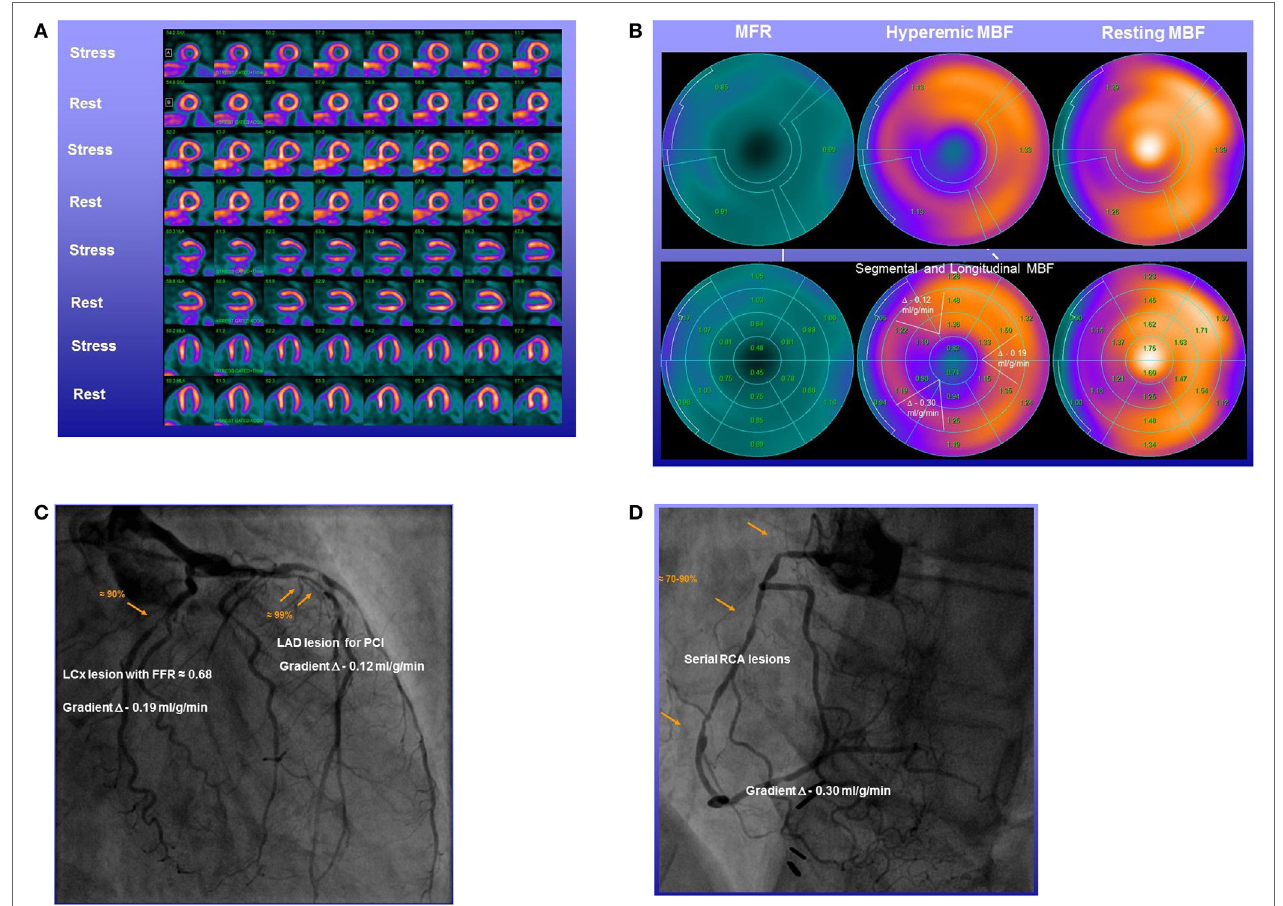
FiGURe 6 | Abnormal longitudinal flow gradient in multivessel CAD. Stress–rest 13 N-ammonia positron emission tomography/computed tomography (PET/CT) myocardial perfusion and flow quantification with 13 N-ammonia PET/CT in a 58-year-old man with effort-induced angina chest pain. (A) Regadenoson-stress and rest 13 N-ammonia PET/CT images in corresponding short-axis (top), vertical long-axis (middle), and horizontal long-axis (bottom) slices. On stress images, a moderate-to-severe decrease in myocardial perfusion, involving the antero-septo-apical and apical wall, is observed that normalizes on rest images to indicate ischemia in the left anterior descending artery (LAD) distribution. (B) Regional myocardial blood flow (MBF) quantification demonstrates abnormally reduced hyperemic MBFs and myocardial flow reserve (MFR) in all three major coronary artery territories of the LAD, left circumflex artery (LCx), and right coronary artery (RCA), respectively (upper panel). Segment MBF analysis unmasks a decrease in MBF from the mid to distal segments with a mean longitudinal MBF gradient during hyperemic flow in the LAD (0.12 ml/g/min), LCx (0.19 ml/g/min), and RCA (0.30 ml/g/min) (lower-middle panel). (C) Invasive coronary angiography of the left coronary artery in this patient showed a long 99% stenosis in the mid-LAD that was responsible for the observed stress-induced perfusion defect of the antero- septo-apical and apical walls on 13 N-ammonia PET/CT perfusion images. In addition, large caliber diagonal branches of the LAD present a ≈ 70–80 and ≈ 80–90% stenosis, respectively. The proximal LCx has a proximal ≈ 80–90% stenosis. Invasively measured fractional flow reserve (FFR) of the proximal LCx lesion was abnormally reduced with 0.68 emphasizing also the hemodynamic significance of this lesion. (D) Invasive coronary angiography of the RCA demonstrates serial epicardial lesion from the proximal to mid segments of ≈ 70–90%, respectively [adapted with kind permission of Valenta et al.